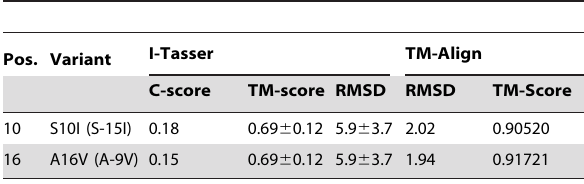
Table 4. Structure alignment of ab initio SOD2 mutant models with the ab initio wild-type